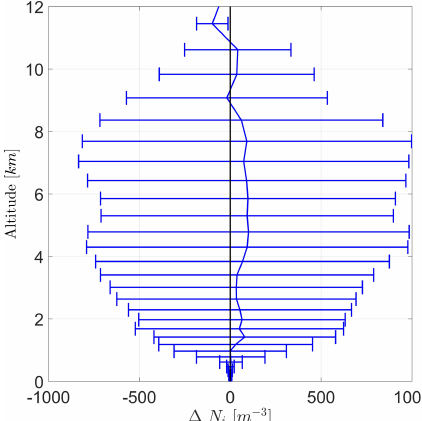
Figure 9. Vertical profile of the difference of the ice crystal number concentration ( (cid:49)N i ) between the cases BIO and DST with the same configuration for averaging as Fig.